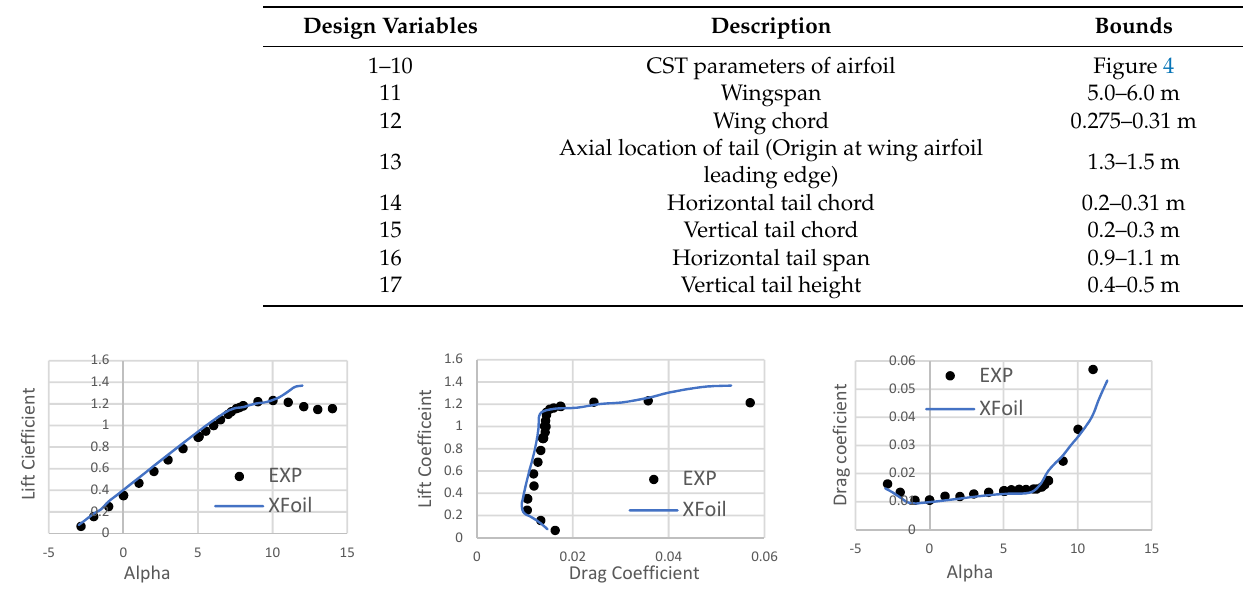
Table 4. Design variables of solar UAV.